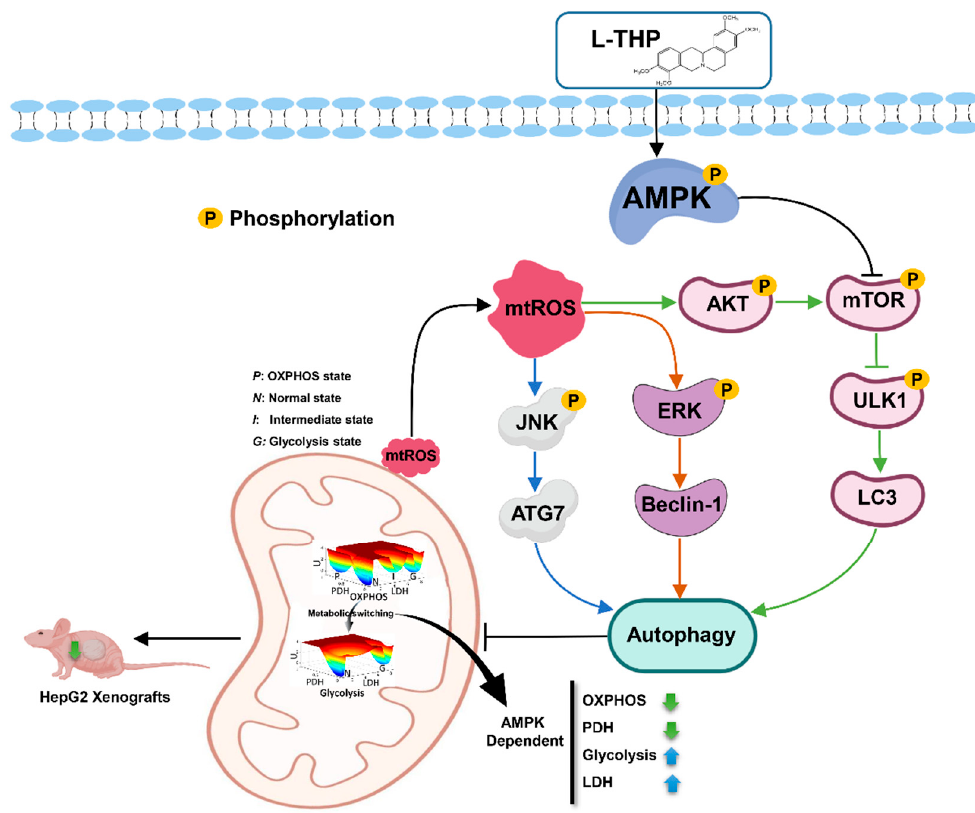
Figure 6. AMPK-mediated metabolic switching is high effective for L-THP to reduce HCC tumor growth in mice.